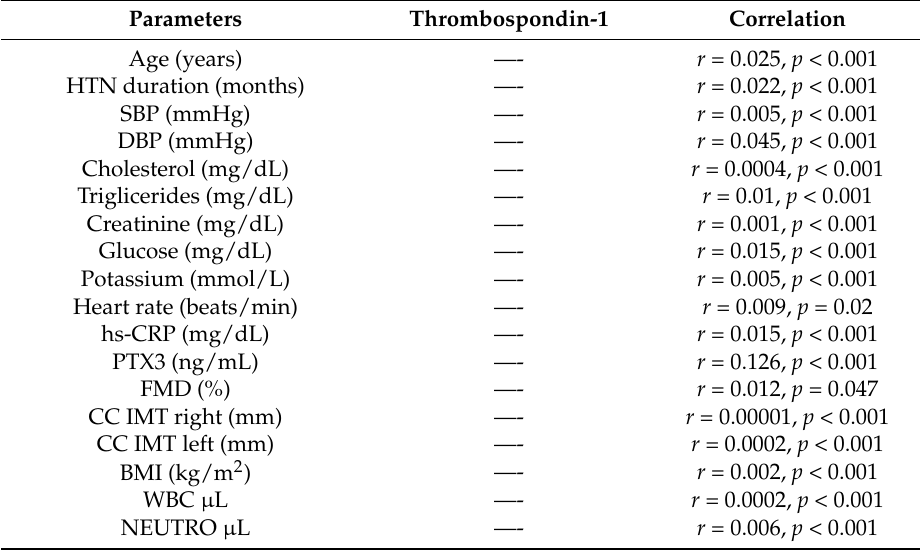
Table 5. Correlation of TSP-1 plasma levels with all data in Group C.